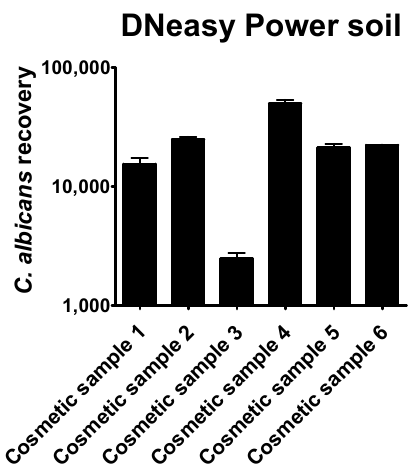
Figure 4. Histogram plot showing Candida albicans recovery among different cosmetic samples obtained by qPCR using the Power Soil kit in automation. On the X axis, the name of the commercial kit employed is reported, while on the Y axis, the number of cells extrapolated from the linear regression is described.